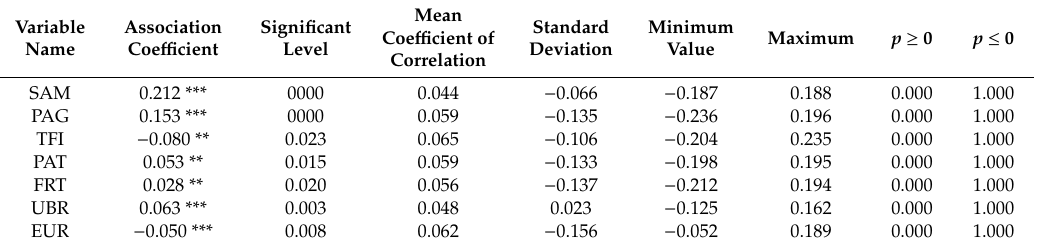
Table 10. Analysis of the association matrix T and QAP of influencing factors.